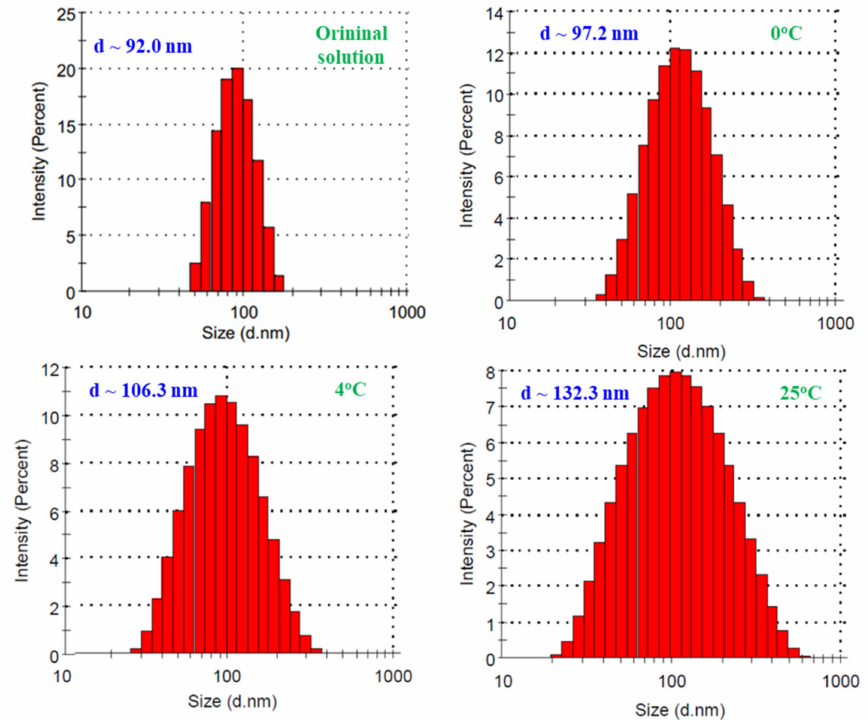
Figure 9. Particle size and size distribution of SeNPs/ β -glucan solution after storage for 60 days at various temperatures.